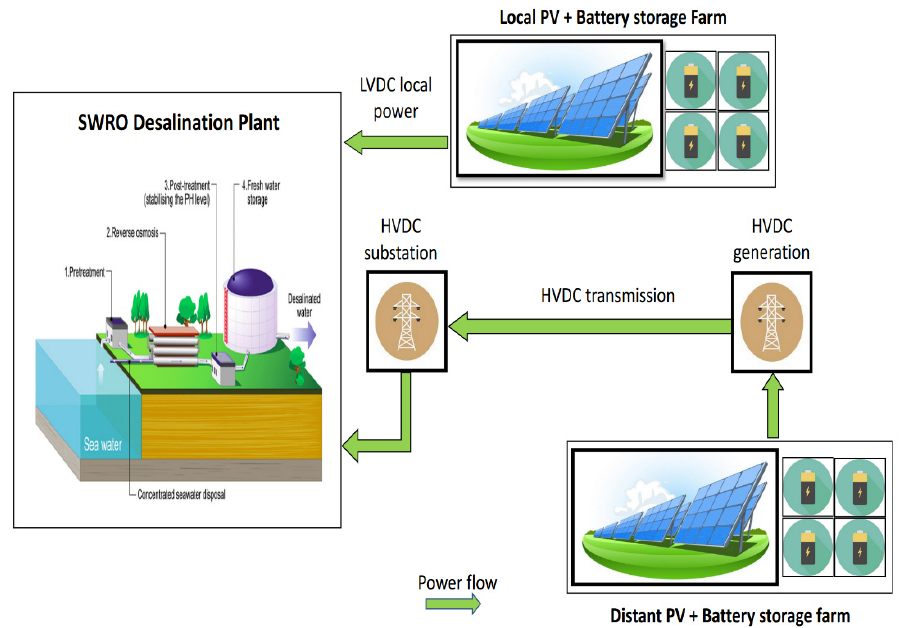
Figure 6. End-to-end DC power network for desalination plant. In this figure, PV, SWRO, HVDC and LVDC represent Photovoltaics, Seawater Reverse Osmosis, High voltage Direct Current and Low voltage Direct Current (LVDC) respectively.